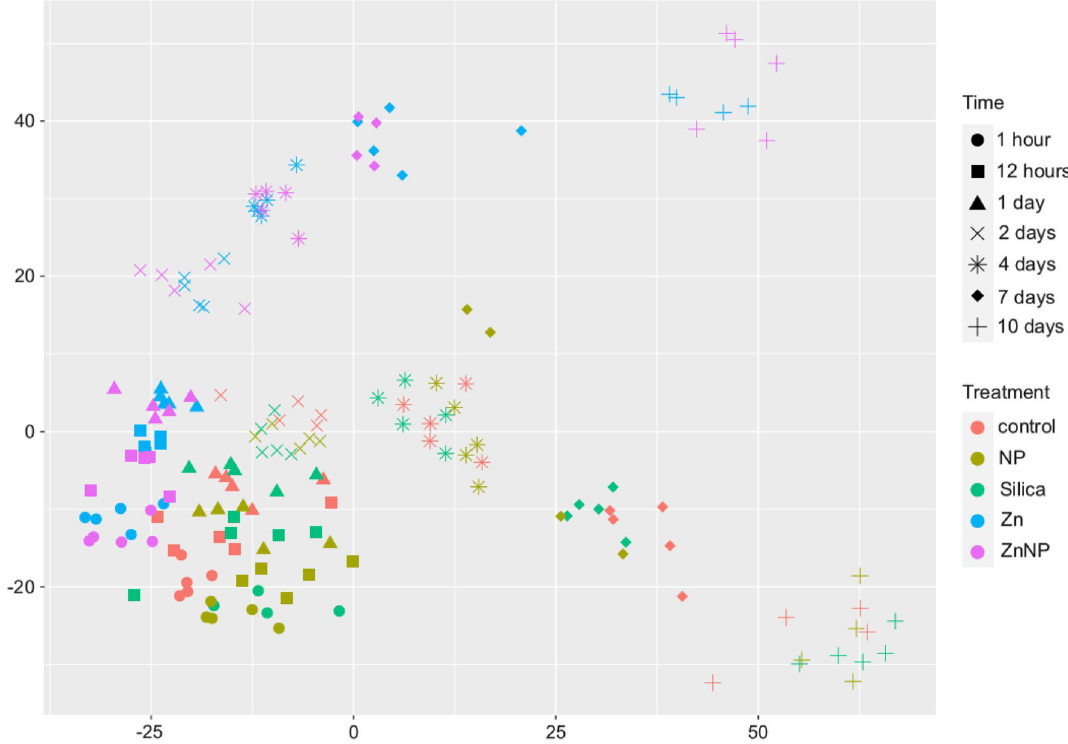
Figure 2. Non-metric multidimensional scaling (NMDS) ordination plot of individual treatments over time showing their community development and differentiation during the time-course of the experiment. A stress value of 0.105 denotes a decent ordination representation. Treatments are color-coded and sampling points are shape-coded. It can be observed that the x-axis represents time and the y-axis individual treatments Samples close to each other are more similar, thus their community structure is more similar than the community structure of more distant samples. The distance between individual samples is rank-based and not linear. The differentiation of the Zn and ZnNP treatment compared to the control becomes obvious over time, while there is no differentiation of Si and NP treatment, when compared to the